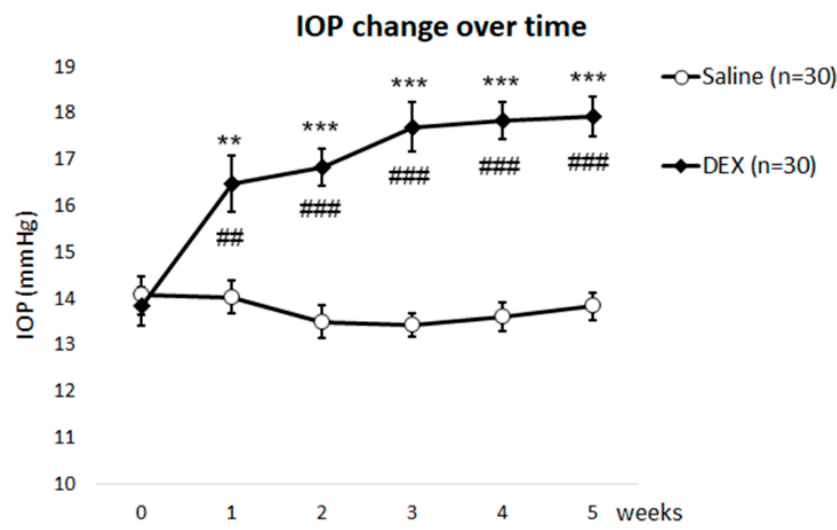
Figure 1. DEX Treatment Increased IOP. Dexamethasone (DEX) treatment increased Intraocular Pressure (IOP) over time. DEX-treated eyes showed significantly increased IOP at all time points after treatment compared to the saline-treated controls (**: p < 0.01; ***: p < 0.001). There was also a significant increase when compared to its own baseline (##: p < 0.01; ###: p < 0.001). IOP change during five weeks of treatment was further analyzed by using three-way ANOVA with three factors: treatment (DEX vs. saline), time, and sex. The results showed that there was a significant main effect of the type of treatment (F (1, 56) = 83.88, p < 0.0001). There was also a significant main effect of time (F (5, 280) = 7.256, p < 0.0001) but no significant main effect of sex (F (1, 56) = 0.2556, p = 0.6151). Therefore, eyes from both sexes were combined for other analyses. There was also a significant interaction between the type of treatment and time (F (5, 280) = 11.18, p < 0.0001). No significant interaction was found between time and sex (F (5, 280) = 1.331, p = 0.2594) or between the type of treatment and sex (F (1, 56) = 1.163, p = 0.2855). There was no significant interaction between the type of treatment, time, and sex (F (5, 280) = 0.7144, p = 0.6131). These data suggested that DEX increased IOP significantly over time, while sex did not affect the IOP